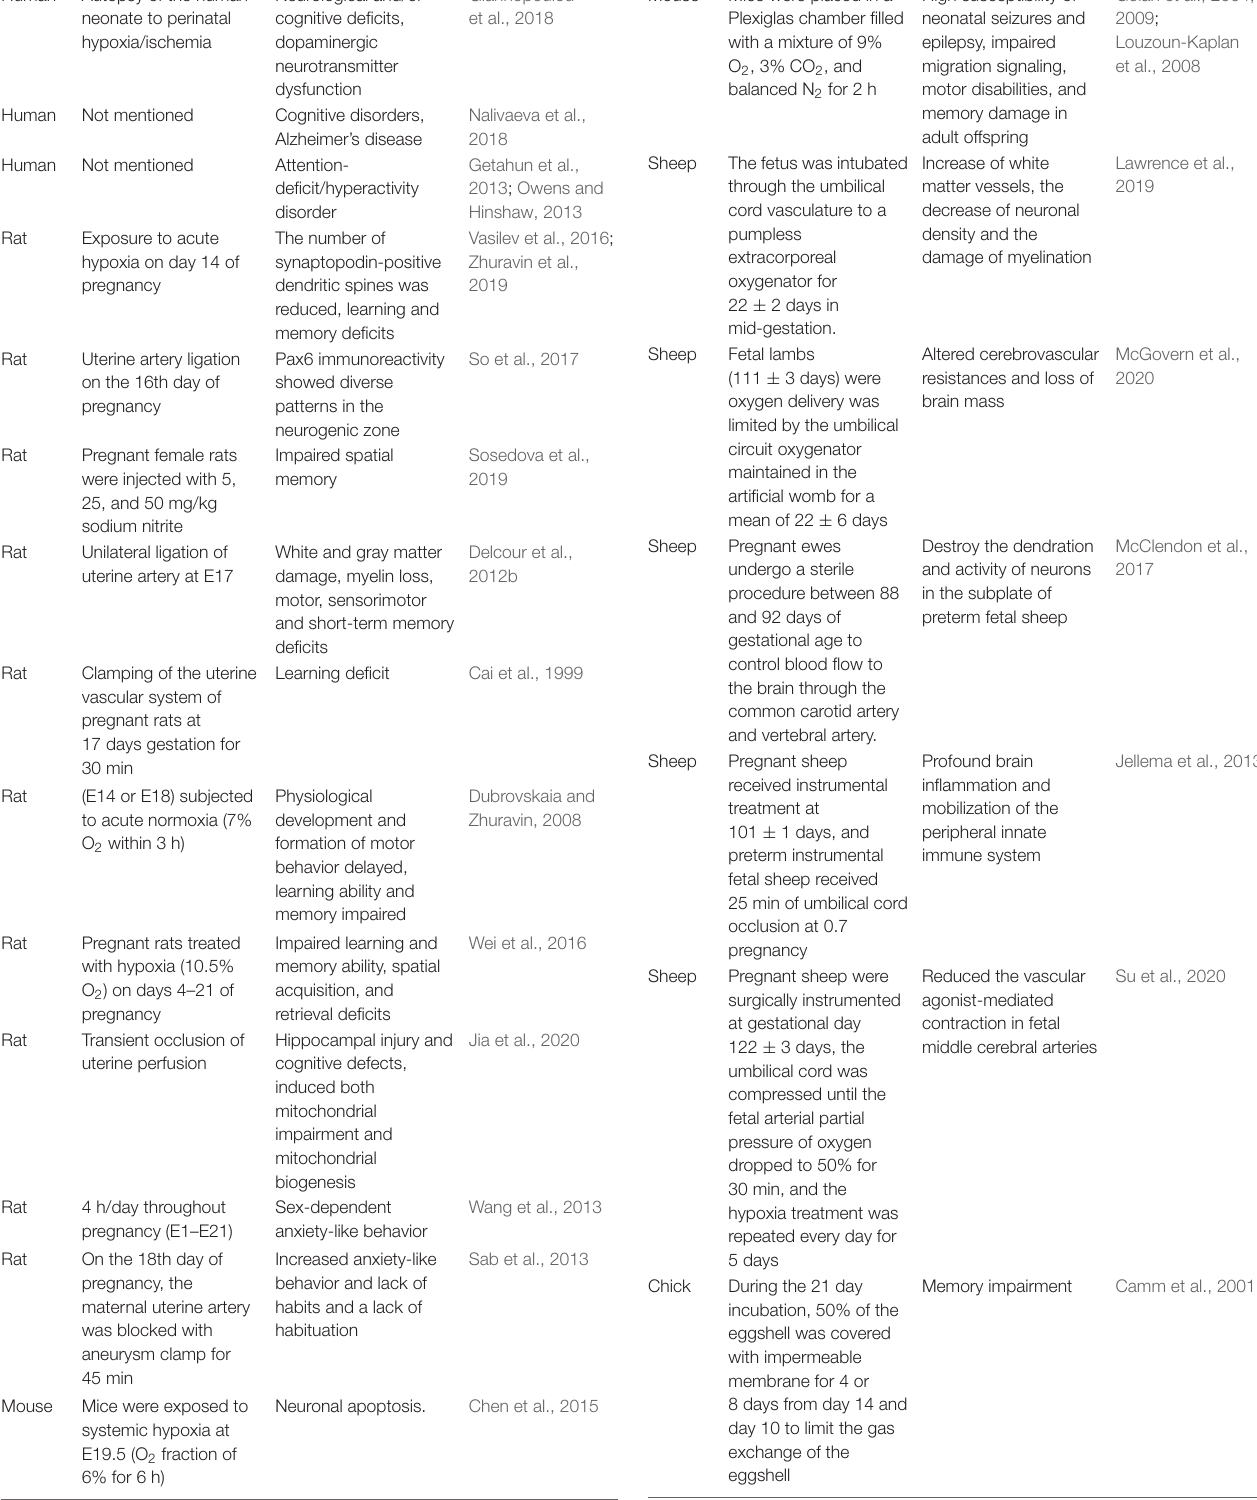
TABLE 1 | Animal models used for prenatal hypoxia